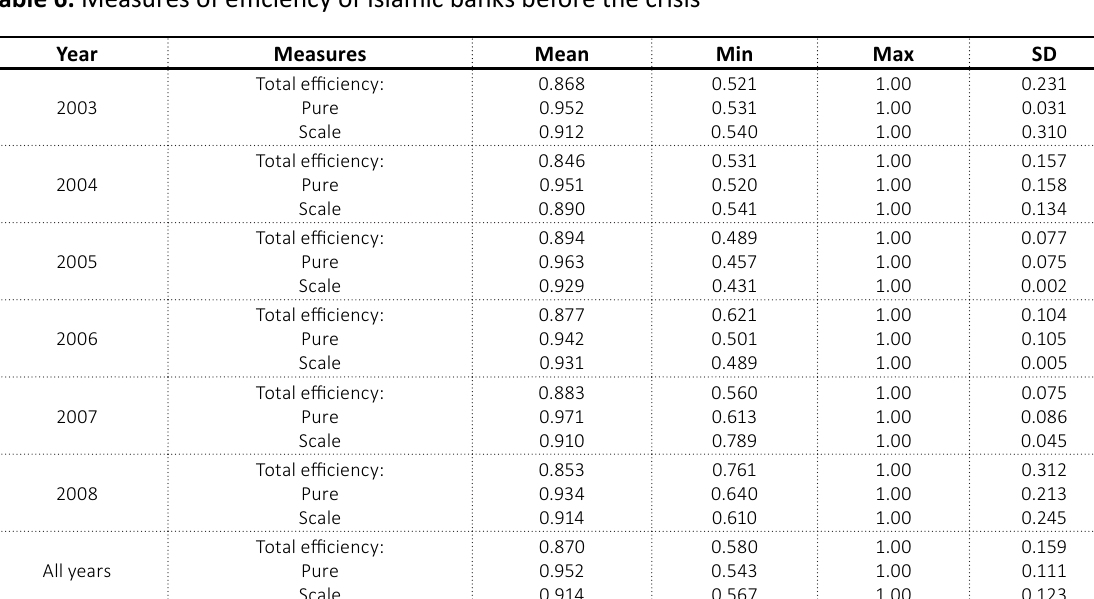
Table 6. Measures of efficiency of Islamic banks before the